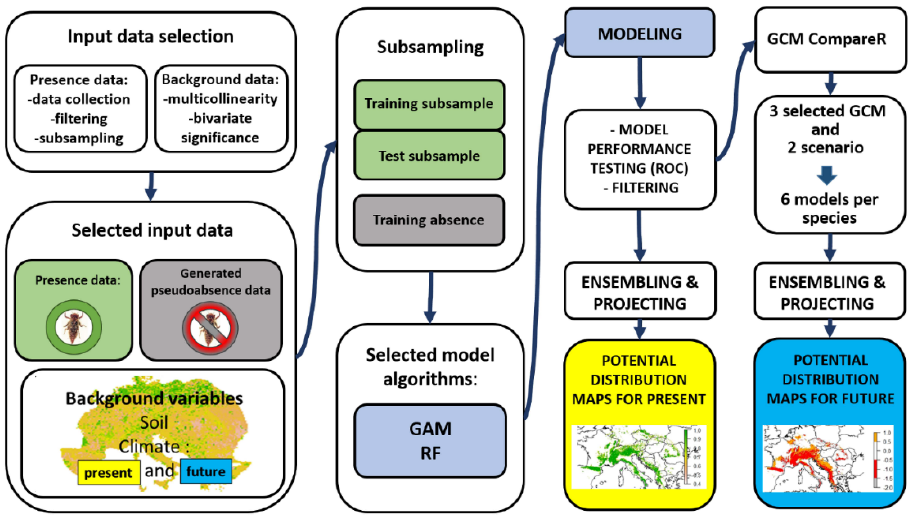
Figure 1. The schematic flowchart of the modeling process.